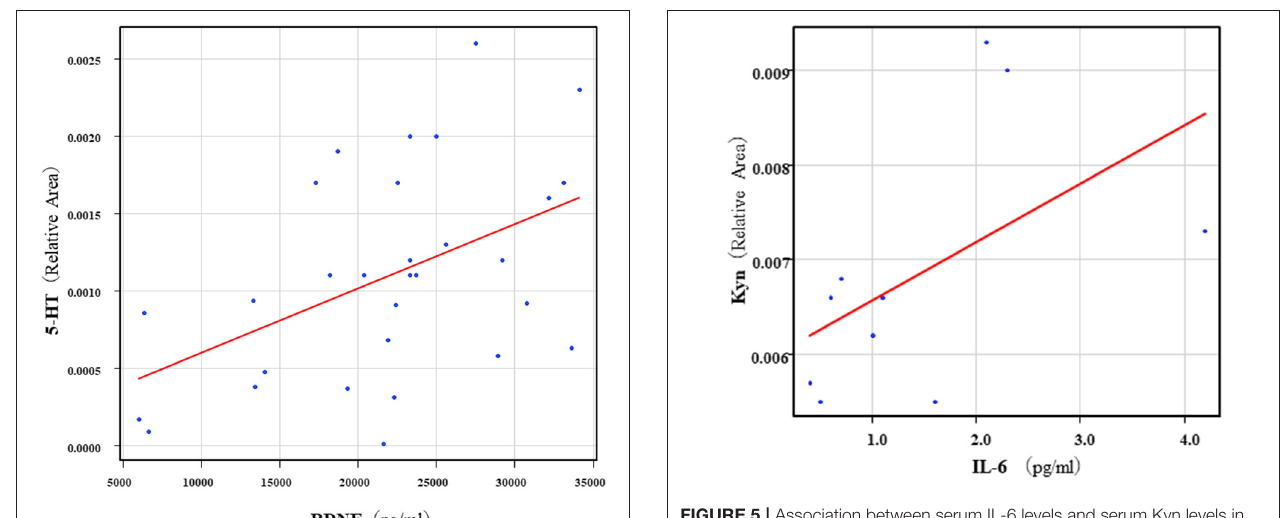
FIGURE 5 | Association between serum IL-6 levels and serum Kyn levels in the healthy control group. A positive correlation was found between the serum IL-6 levels and the serum Kyn levels ( r = 0.64, p = 0.046) in the healthy control group.